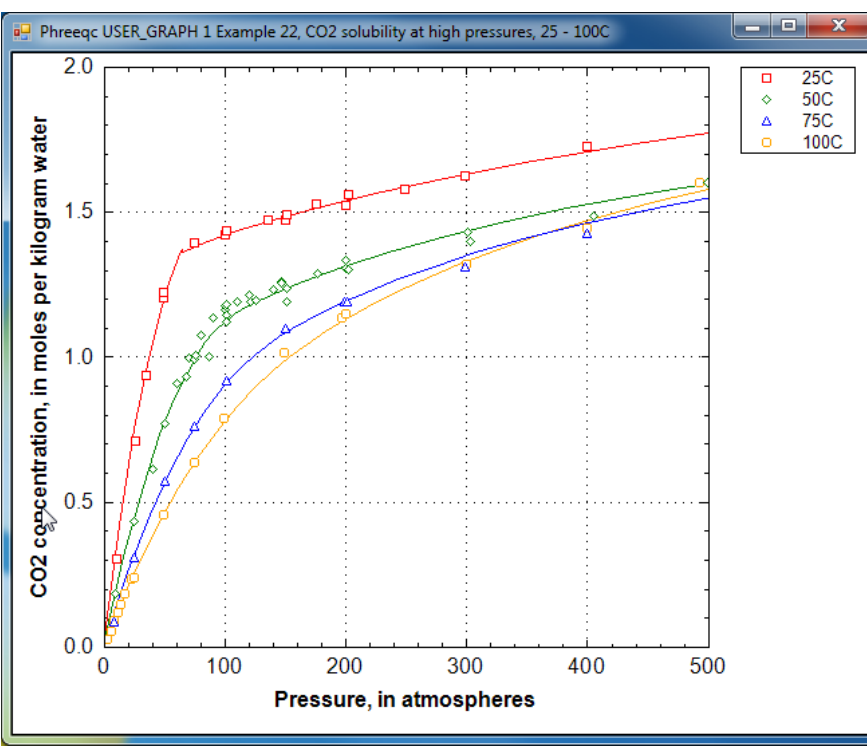
Figure 27. Solubility of CO 2 gas as a function of gas pressure at 25, 50, 75 and 100 °C. Data points are from compilations by Duan and others (2006) and Spycher and others (2003); lines are calculated with